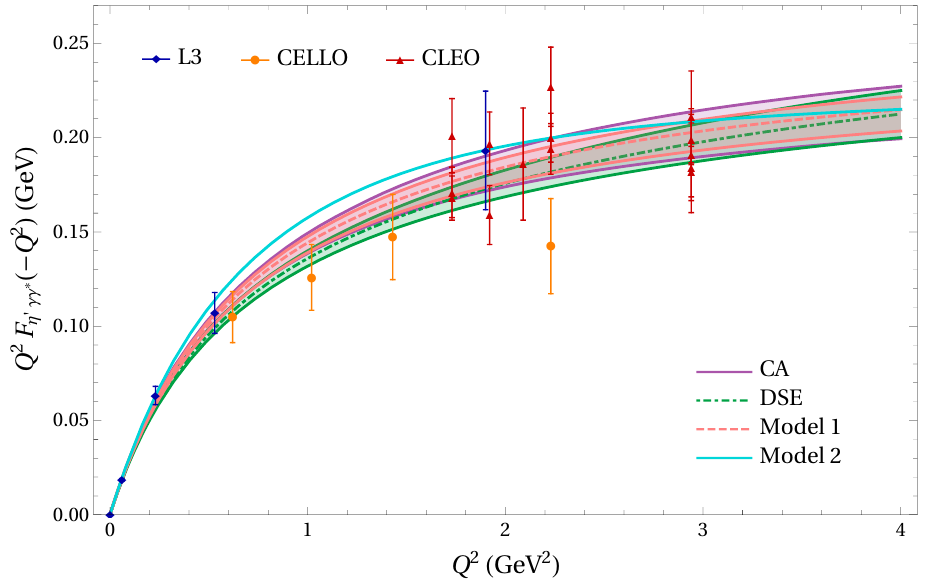
Figure 31. Singly-virtual (cid:17) 0 TFF in the low- Q region. The large- N c Regge model, \Model 1" (4.34), is indicated by the pink band with the dashed curve. Our alternative TFF model, \Model 2" (B.1), is indicated by the solid cyan curve. The purple band is the CA result from ref. [49]. The green band with the dot-dashed curve is the DSE result from ref. [50]. The data are from L3 [127], CELLO [115], and CLEO [116].